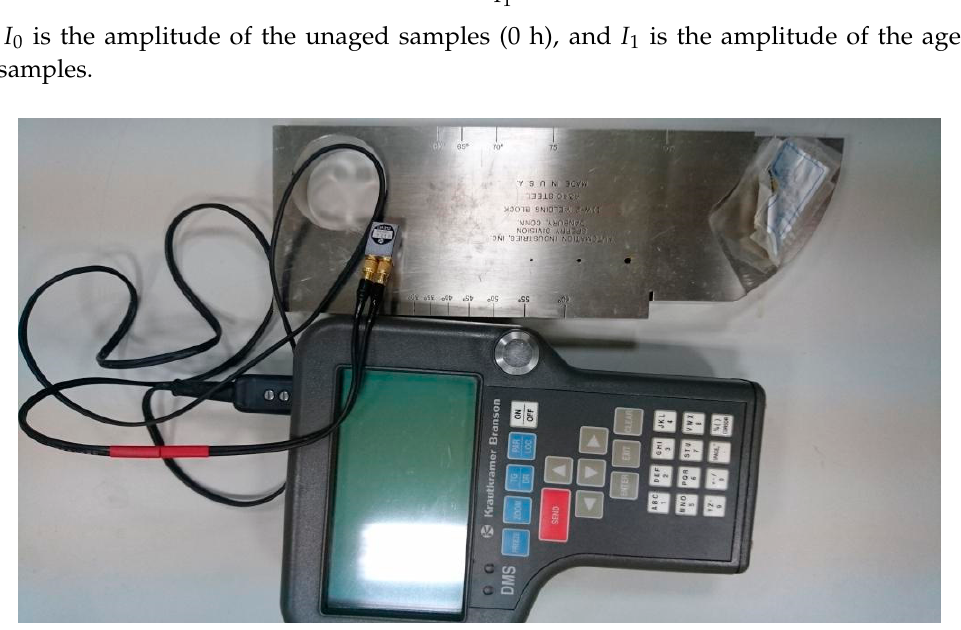
Figure 1. The commercial ultrasonic thickness gauge and a calibration block.